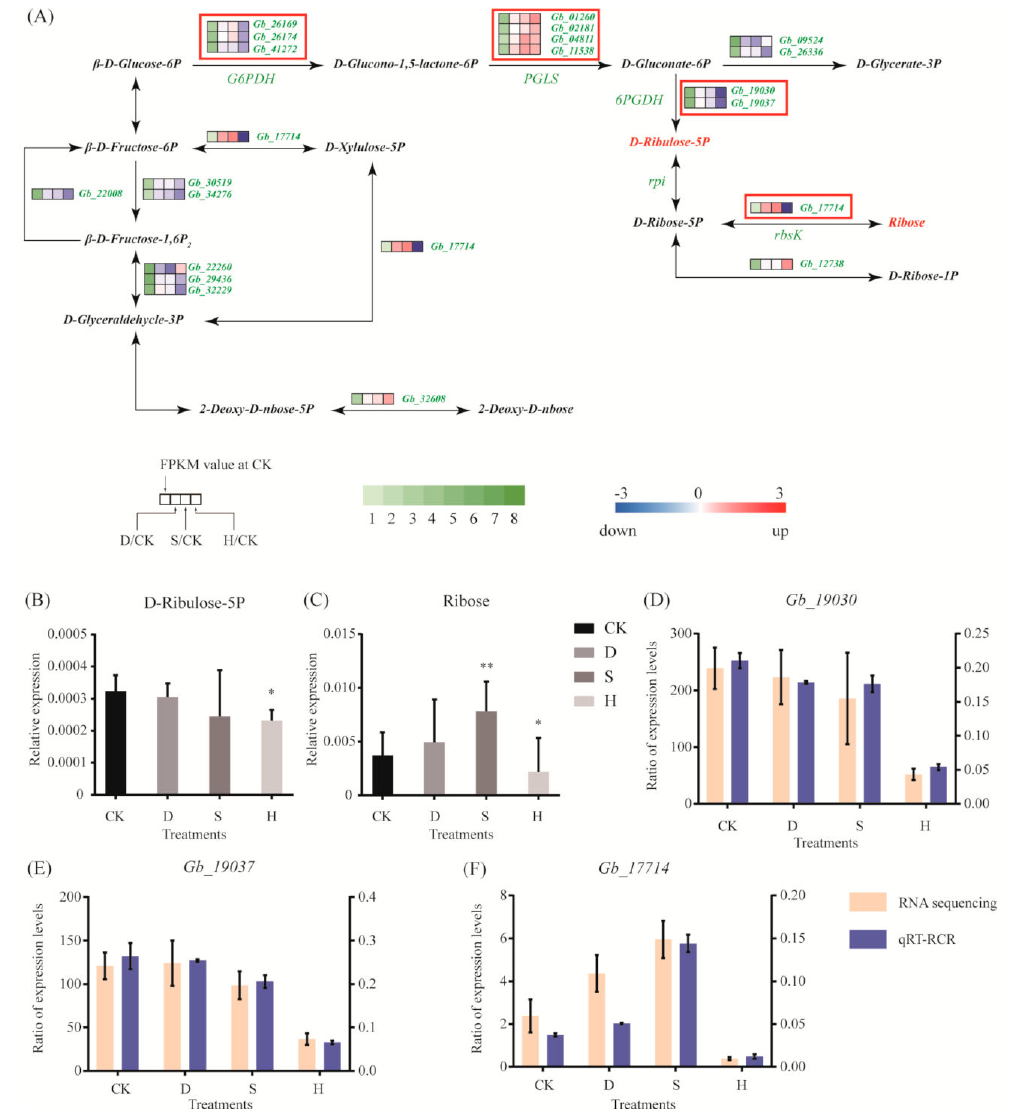
Figure 3. Gene expression and metabolites involved in respiratory metabolism. ( A ) DEGs associated with the respiratory pathway. Red and blue indicate upregulation and downregulation, respectively. Red frames indicate the upregulated or downregulated genes discussed in the main text. ( B , C ) Expression of ( B ) D-ribose-5P and ( C ) ribose. Error bars represent the mean ± SD; n = 5; * / **, p < 0.05 / 0.01, respectively, compared with CK. ( D – F ) Expression of ( D ) Gb_19030 (6PGDH), ( E ) Gb_19037 (6PGDH), and ( F ) Gb_17714 ( rbsK ), as determined by qRT-PCR. Error bars represent the mean ± SD; n = 3. CK: Control; D: Drought; S: Salt; H: